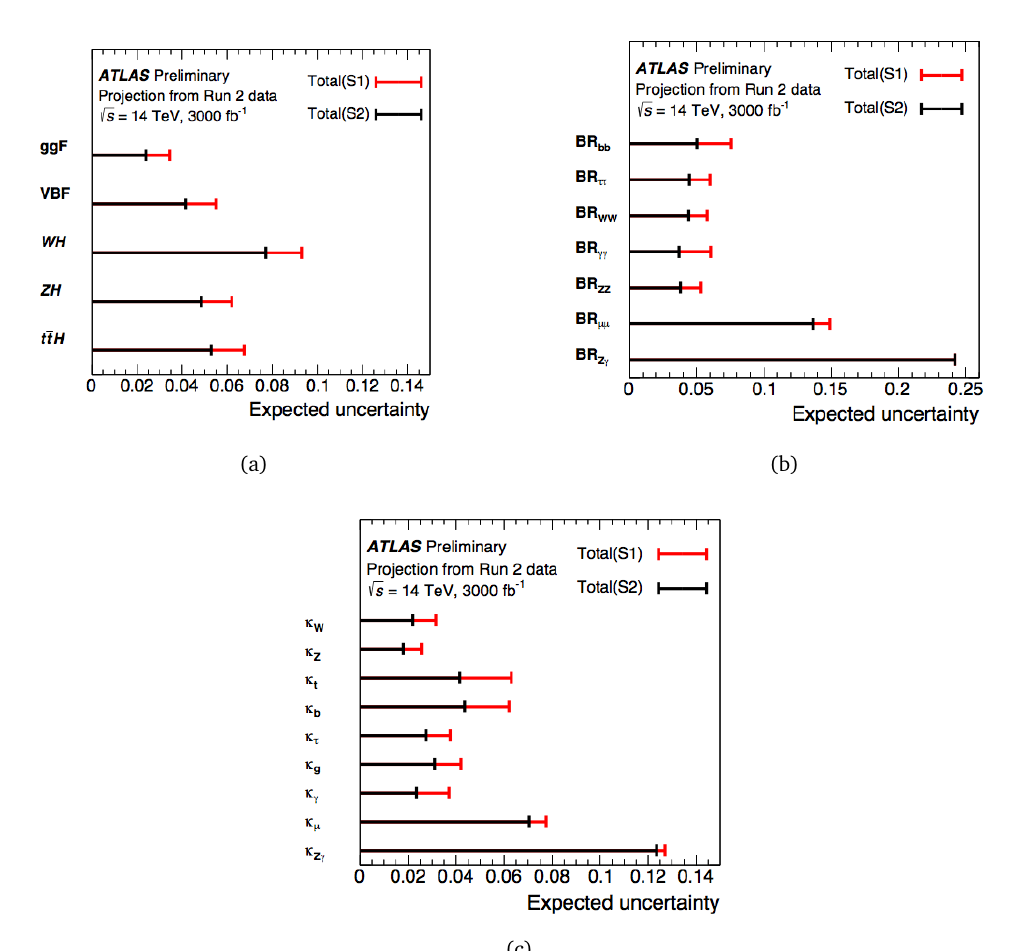
Figure 2: Expected uncertainty on the measurements of the cross sections for the g gF , V BF , W H , ZH and ttH production modes normalised to their SM predictions assuming SM branching fractions (a), the expected uncertainty on the branching ratio measurements for the γγ , ZZ , WW , ττ , bb , µµ (b) and Z γ decay channels normalised to their SM predictions assuming SM production cross section and the expected uncertainty on the measurement of each Higgs boson coupling modifier per particle type with effective photon, gluon and Z γ couplings (c), for the two systematic uncertainties scenarios S1 (red) and S2 (black) [ 23 ]